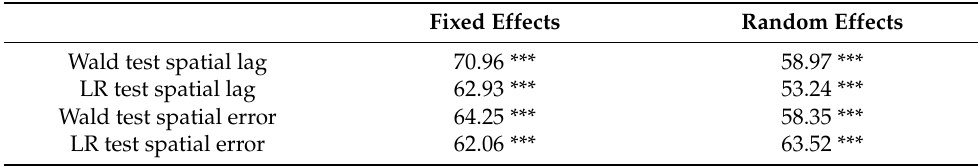
Table 4. The regression results of the likelihood ratio test and Wald test.